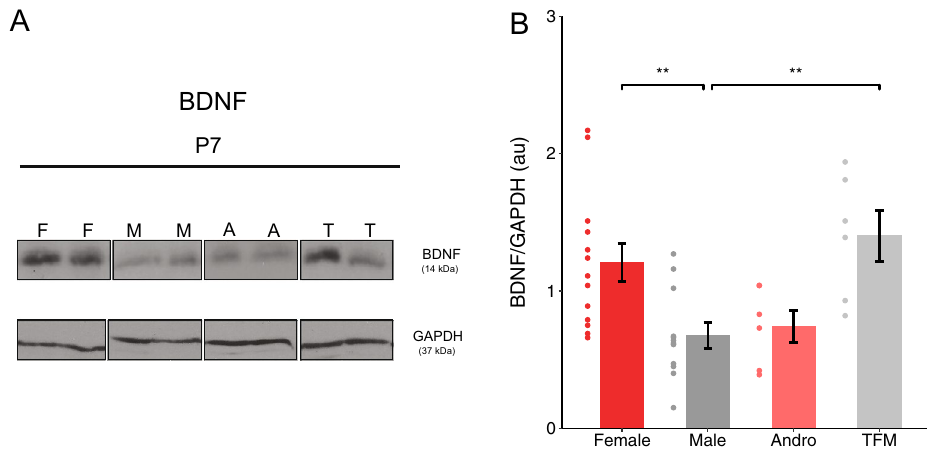
Figure 5. Perinatal testosterone negatively correlates with BDNF expression levels during the first postnatal week. ( A ) Western blot analysis of mature BDNF (14 kDa) expression levels in the hippocampus of different experimental groups at P7. Each lane represents a different animal. Blot shows representative samples of different sex groups (images were cropped from different gels). ( B ) Quantification revealed that the expression of mature BDNF is significantly lower in male when compared to female and testosterone-insensitive male rat pups (F: 1.21 ± 0.14 au, n = 13 rats from 4 litters; M: 0.68 ± 0.09 au, n = 10 rats from 4 litters; A: 0.74 ± 0.12 au, n = 6 rats from 3 litters; TFM: 1.4 ± 0.19 au, n = 6 rats from 3 litters; One-way ANOVA with Tukey’s post hoc analysis, F × M: p = 0.009; TFM × M: p = 0.007). Dots represent individual data points. F females, M males, A andro/testosterone-treated females, T TFM/testosterone-insensitive males. Graphs represent mean ±